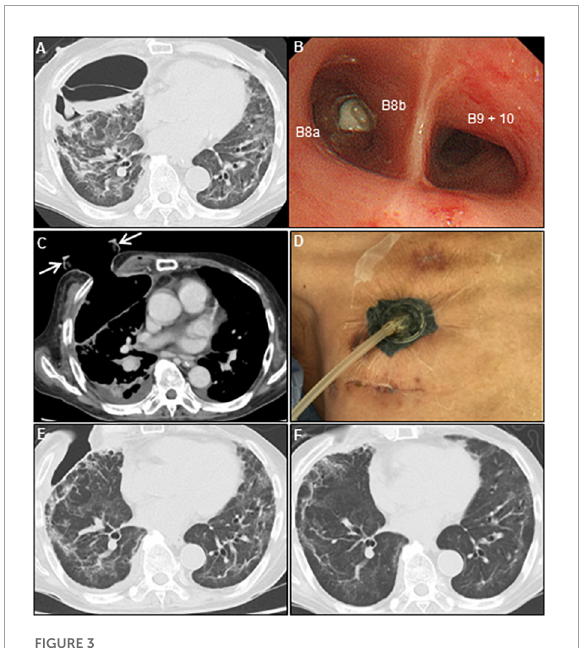
FIGURE3 Multidisciplinary approach for persistent air leaks. (A) Chest CT on day 70 shows empyema and dense pleural thickening with air-fluid level. (B) Bronchoscope shows an endobronchial valve deployment inserted into the right B8b segment. (C) Post-minimally invasive OWT using a wound retractor (white arrows). (D) VAC system. Chest CT on day 97 (E) and 143 (F) show re-expansion of the collapsed lung parenchyma, and a repair of the chest wall after VAC therapy. CT, computed tomography; OWT, open-window thoracostomy; VAC, vacuum-assisted